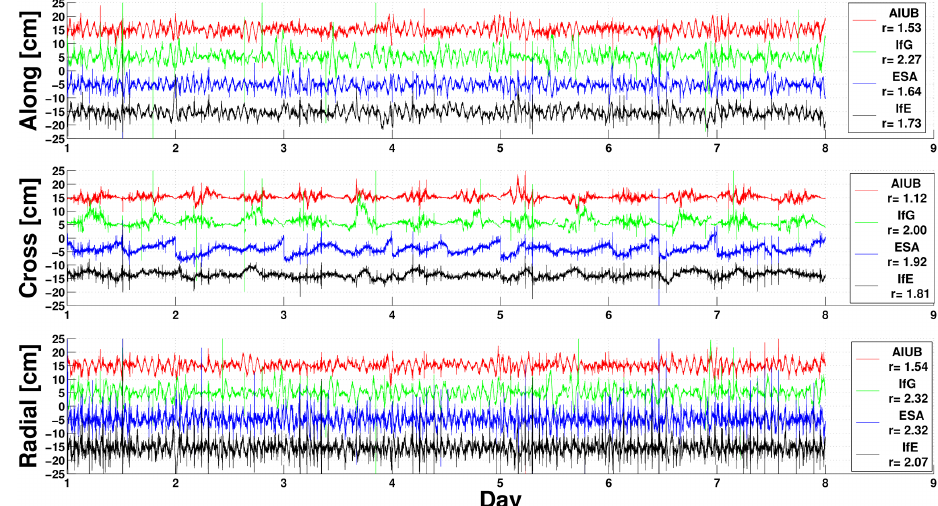
Figure 11. Differences of kinematic orbits with respect to ESA reduced-dynamic orbits of Swarm C of different institutes from DoY 1 to 7, 2016. The time series are intentionally shifted by 15, 5, − 5 and − 15cm for AIUB (red), IfG (green), ESA (blue) and IfE (black), respectively. The legend gives the rms in cm. Table 4. rms and mean of position residuals of IfE and ESA kinematic orbits with respect to ESA reduced-dynamic orbits for Swarm A, B and C during 1 year (DoY 245, 2015 to DoY 244, 2016). The values for ESA kinematic orbits are given in brackets. Swarm rms IfE (ESA) [cm] Mean IfE (ESA)[cm] Along Cross Radial Along Cross Radial A 1.67 (2.05) 1.41(1.87) 2.30 (2.66) 0.06 ( − 0 . 15) 0.19 (0.30) 0.12 (0.16) B 1.47 (1.61) 1.25 (1.41) 1.84 (2.12) 0.05 ( − 0 . 14) 0.27 (0.26) 0.14 (0.11) C 1.60 (1.90) 1.32 (1.61) 2.28 (2.55) 0.02 ( − 0 . 15) 0.07